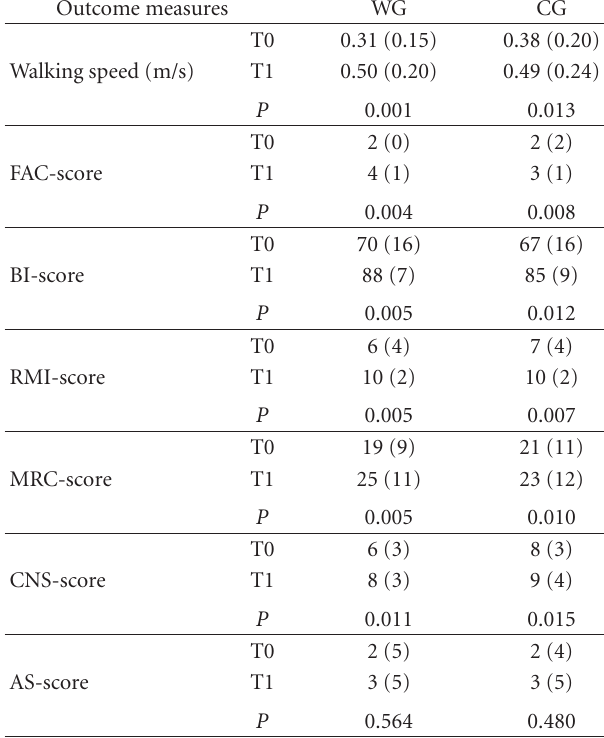
Table 1: Primary outcome measure walking speed (WS): mean (standard deviation) and P values of paired post hoc tests. Secondary outcome measures: median (interquartile range) of the scores, and P values of Wilcoxon signed rank